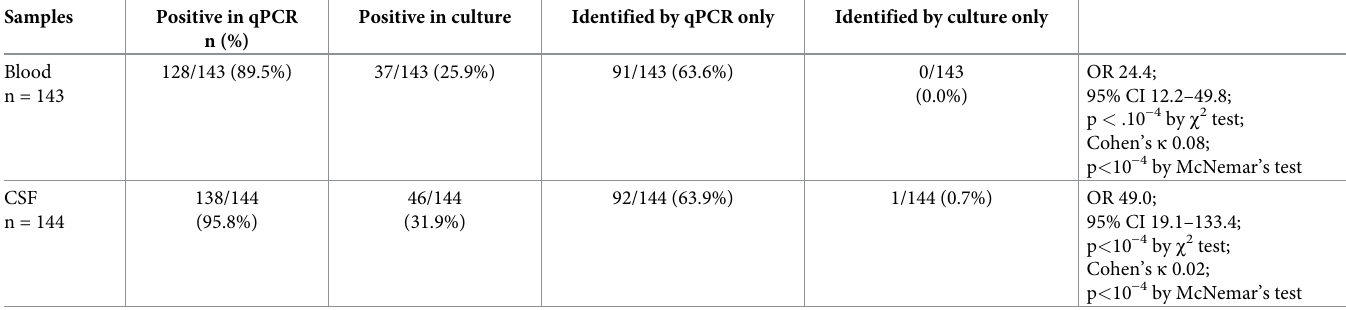
Table 2. Sensitivity of qPCR versus culture in blood or CSF.